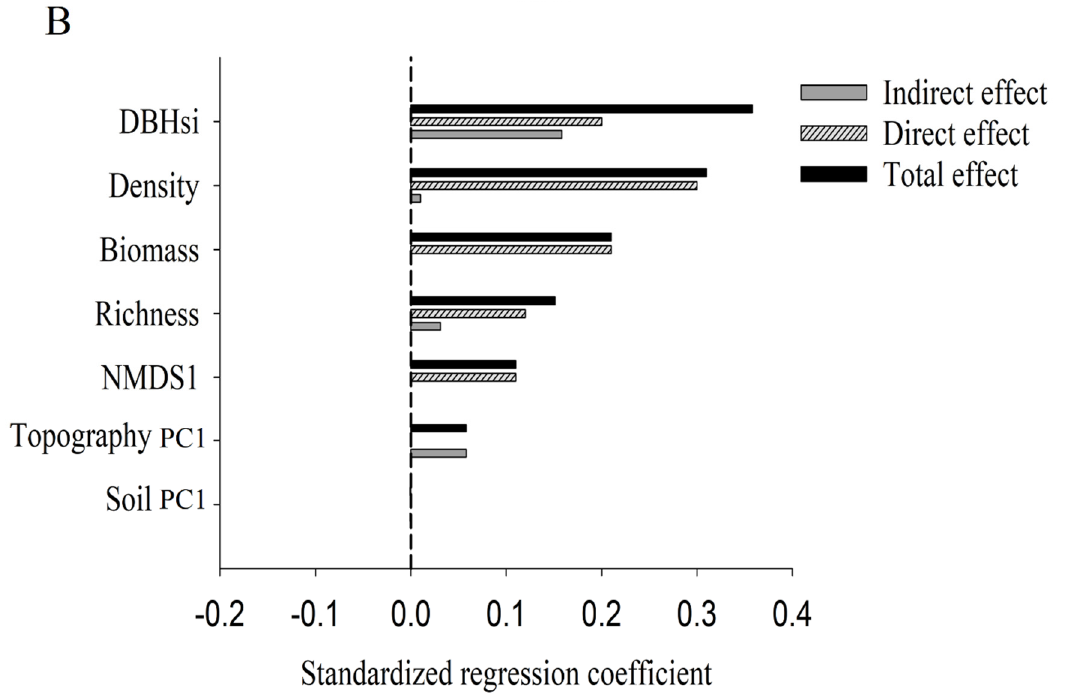
Figure 3. The structural equation model of species diversity, species composition, structural diversity, above-ground biomass, and environmental factors and ∆ AGB, as well as the effects of standardization ( A ); black and red solid lines represent positive and negative effects, respectively. Widths of solid lines indicate path strengths; dotted lines indicate non-significant correlations. Numbers and associated asterisks are standardized path coefficients and significance levels (* p < 0.05; ** p < 0.01; *** p < 0.001) for each path. ( B ) Standardized effects of each factor; black hatched bars show the direct effects, gray bars show indirect effects, and black bars show total effects.